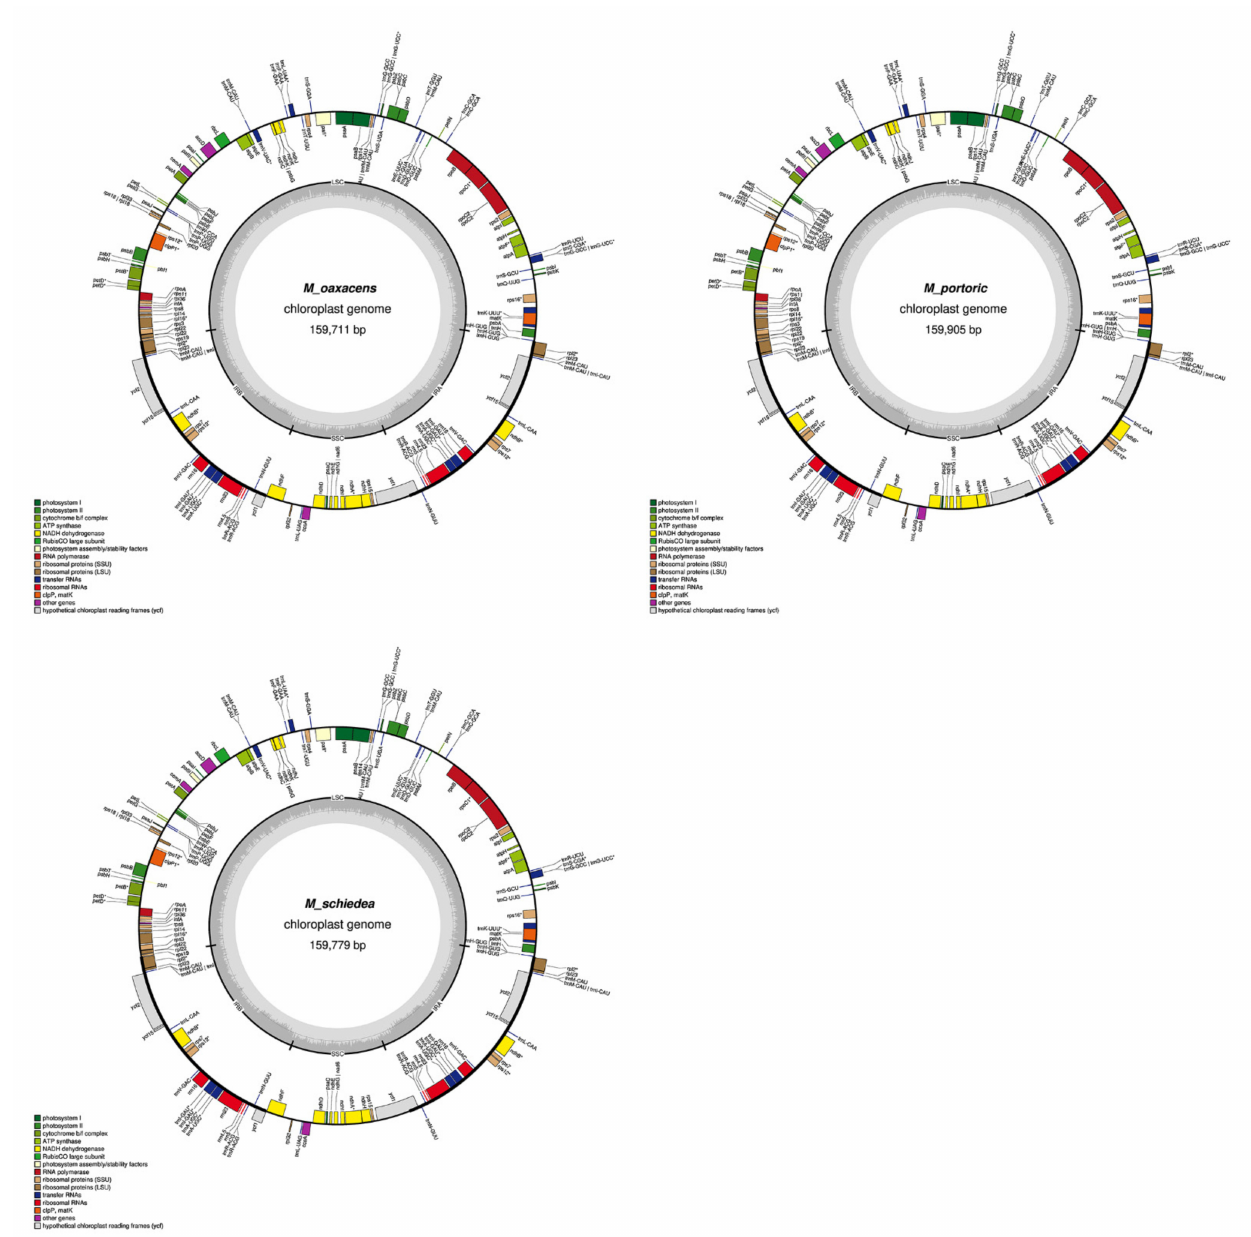
Figure A1. Graphical maps of the 15 newly annotated plastomes generated by